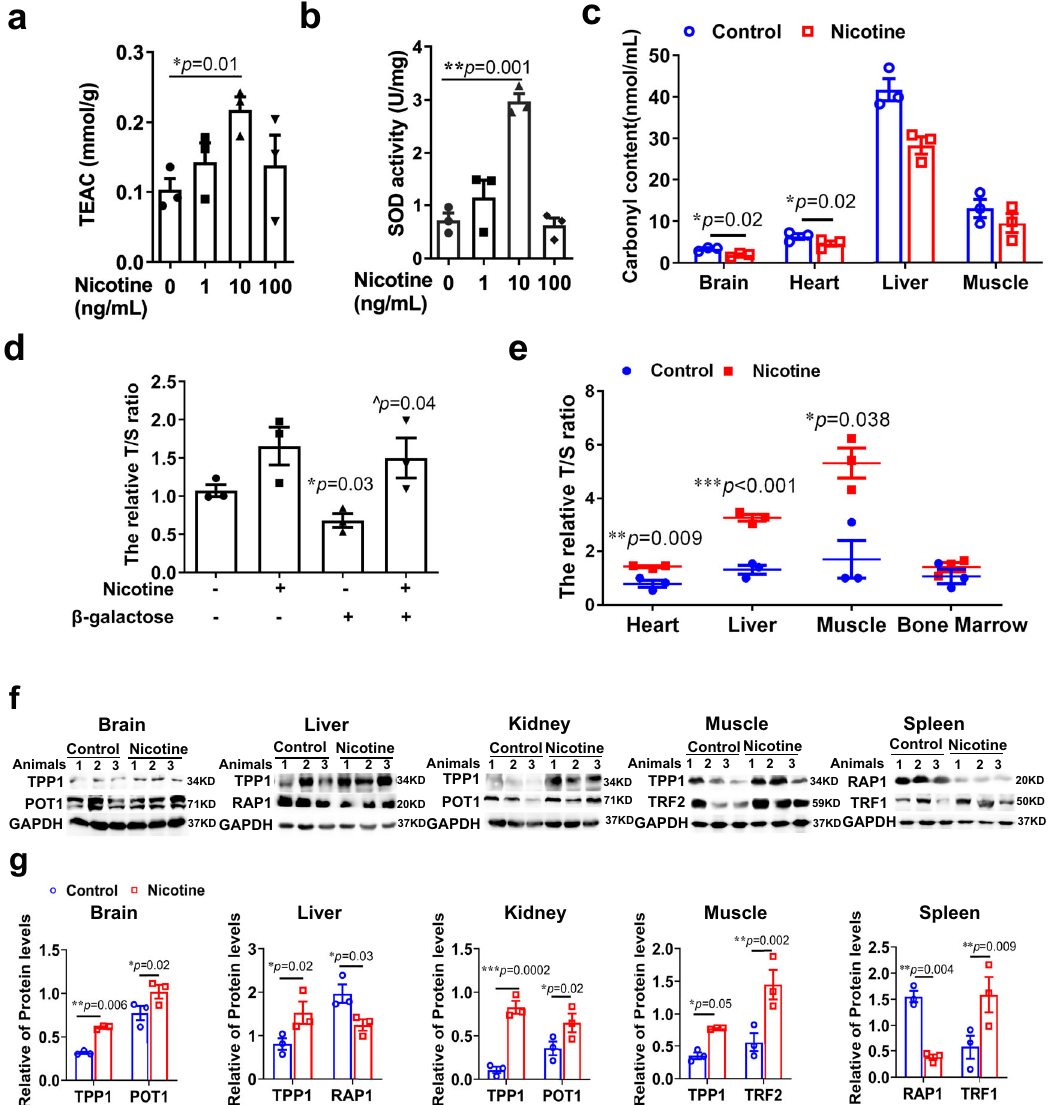
Fig.10|NicotineinhibitedoxidativestressandprotectedTelomerestabilityof ageing mice. a Nicotine 1, 10, 100ng/mL regulated trolox-equivalent antioxidant capacity (TEAC) in HT22 cells treatment for 48h ( n =3 biologically independent samples/group). b Nicotine 1, 10, 100ng/mL regulated CuZn-Mn superoxide dis- mutase (CuZn-Mn SOD) activity in HT22 cells for 48h ( n =3 biologically indepen- dent samples/group). c Nicotine decreased the carbonyl content in brain ( n =3, biologically independent samples/group), heart, liver ( n =3, biologically independentsamples/group),andmuscleofagedmiceadministerednicotinefrom 7 to 13 months. d Telomere length/single copy gene (T/S) ratio of β -galactose-